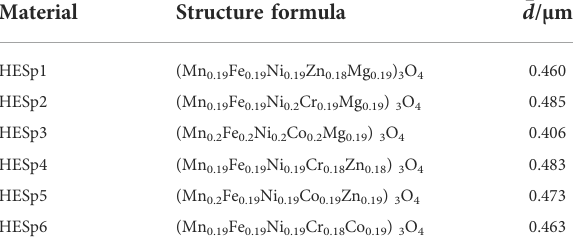
TABLE 2 Overview of the formula based on ICP and the average particle size of the HESp materials. Material Structure